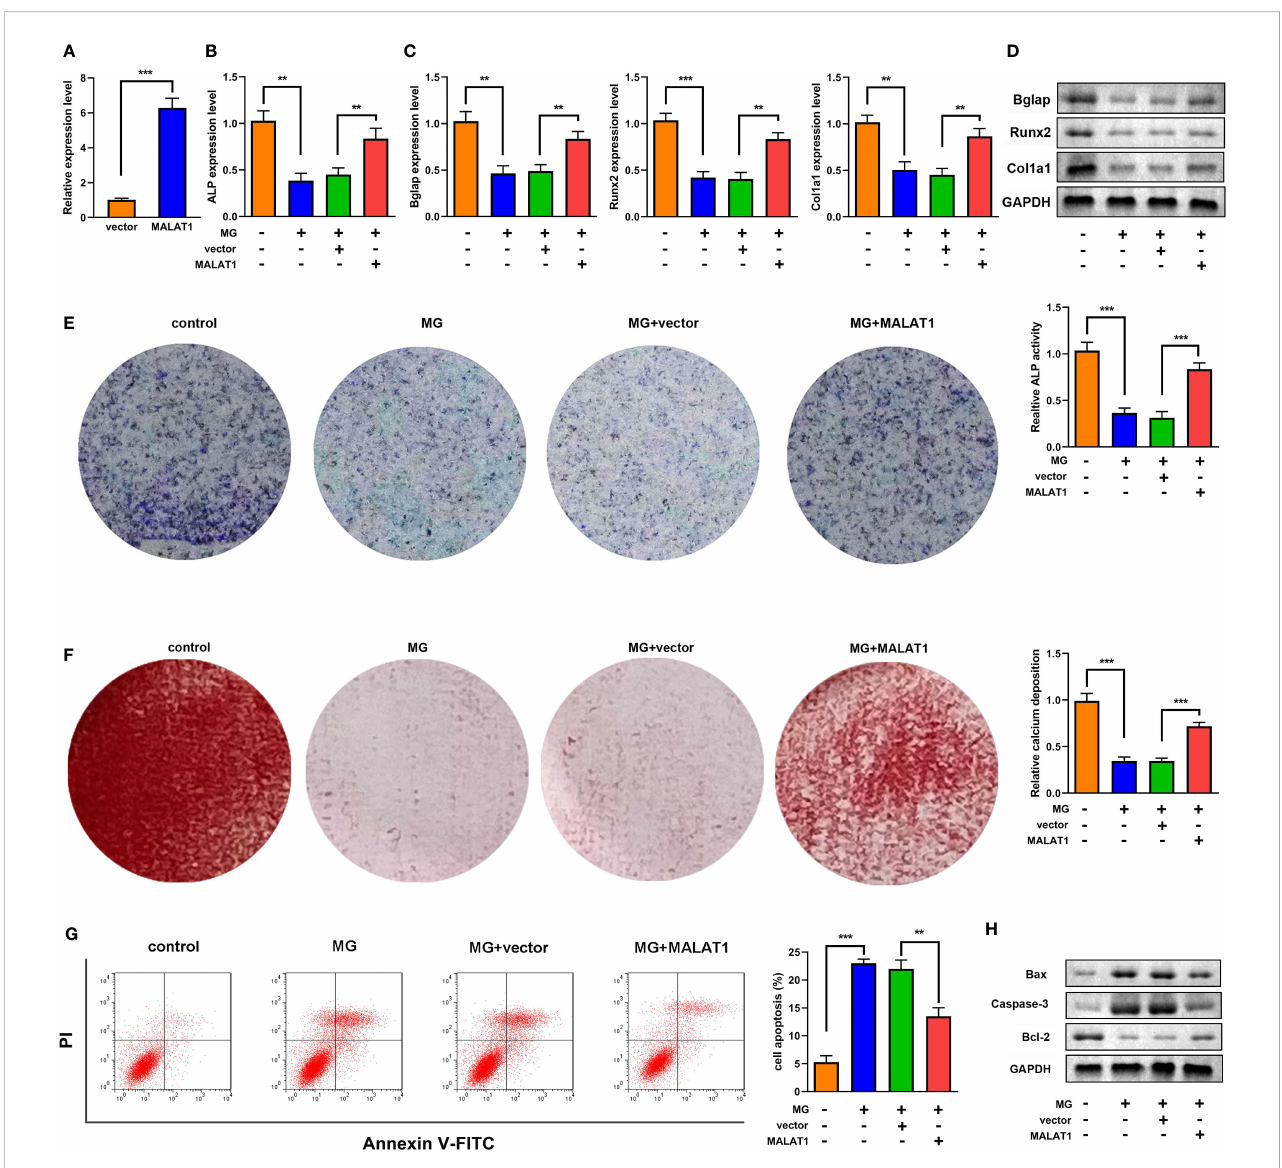
FIGURE 2 MALAT1 facilitated MC3T3-E1 cell osteogenic differentiation and suppressed apoptosis. (A) The transfection ef fi ciency of MALAT1 was determined using RT-qPCR. Then, the MC3T3-E1 cells were treated with MG and transfected with MALAT1. (B) The expression of ALP was determined using RT-qPCR. (C) The mRNA expression of Bglap, Runx2, and Col1a1 was determined using RT-qPCR. (D) The protein expression of Bglap, Runx2, and Col1a1 was detected using Western blot. (E) The ALP activity of MC3T3-E1 cells. (F) Alizarin red staining was used to measure calcium deposit. (G) Cell apoptosis was analyzed by fl ow cytometry, and cell apoptosis rate was quanti fi ed. (H) The protein expression of Bax, caspase-3, and Bcl-2 was detected using Western blot. **P<0.01,